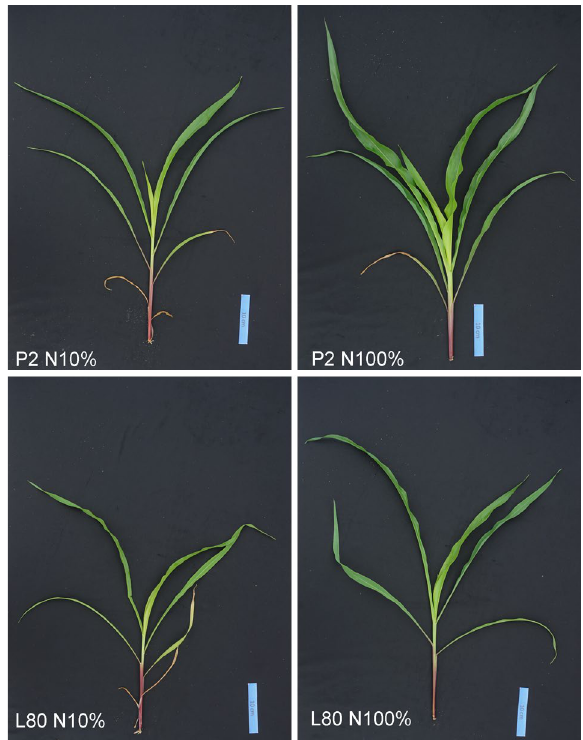
Figure 1. Phenotype of N-efficient (P2) and N-inefficient (L80) inbred lines at the V6 stage under low (N10%) and high (N100%) nitrogen supply.